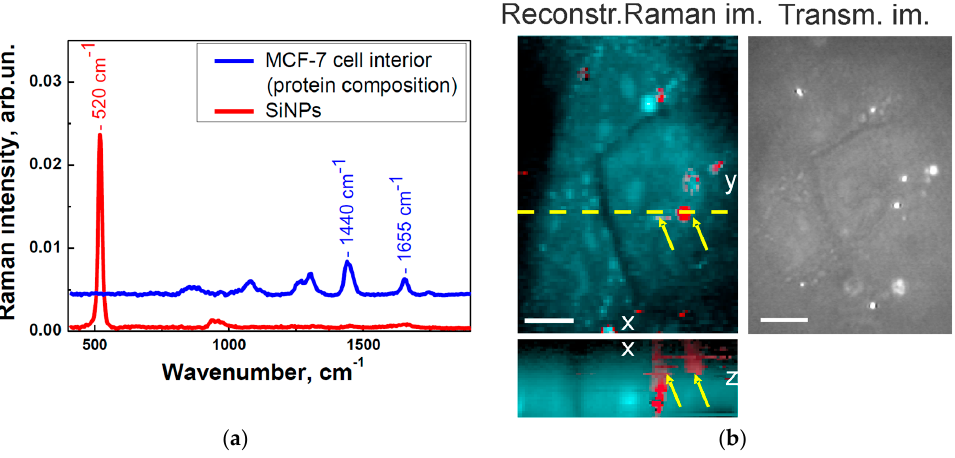
Figure 3. ( a ) Raman spectra of the protein composition (blue line) of the MCF-7 cell interior and of the SiNPs (red line), respectively, after an incubation time of 24 h extracted by applying the vertex-component-analysis (VCA) algorithm; and ( b ) Raman spectroscopy images (xy- and xz-cross-sections of the Raman image reconstructed with VCA) and transmitted-light image (Transm. im.) of MCF-7 cells incubated with SiNPs for 24 h. The SiNPs depicted in red and pointed with yellow arrows are located in the cell cytoplasm depicted in cyan. The scale bar corresponds to 10 µm.